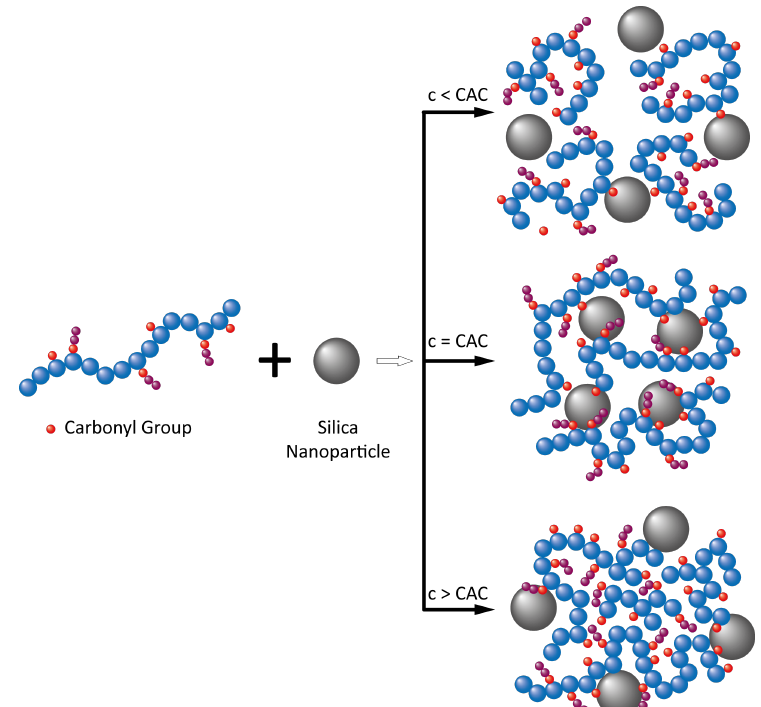
Figure 5. Interaction between hydrophobically associating polyacrylamide (HAPAM) polymer and silica nanoparticles as a function of the polymer concentration. Figure adapted from Ref. [8]. CAC: critical aggregation